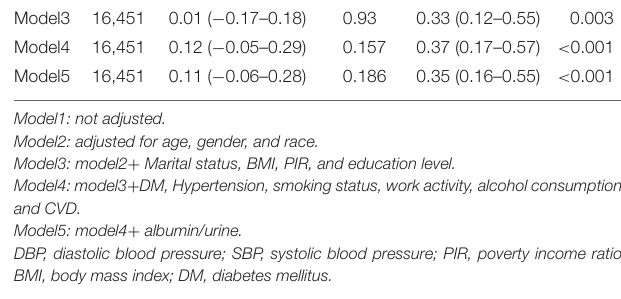
TABLE 3 | Interactive effect of blood lead and HDL on SBP. Models